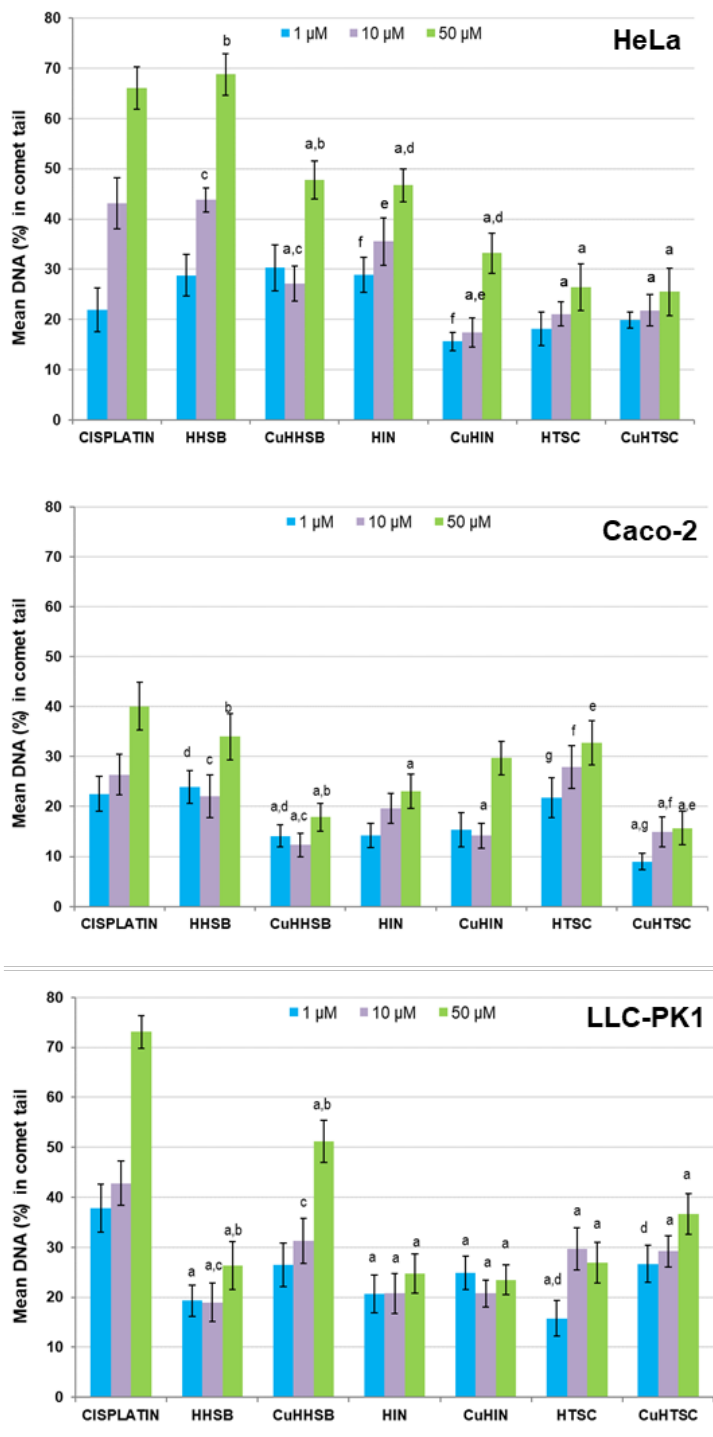
Figure 6. Basic endogenous DNA damage in different cell lines after exposition to tested compounds, expressed as percentage of DNA in the tail of comets in the alkaline comet assay. The number of cells analysed in each treatment was 50. Error bars denote standard error of the mean (S.E.M). Results significantly different from: a cisplatin, b–g Cu ligand; ANOVA ( p ≤ 0.05). In the case of the Caco-2 cell line (Figure 6), 50 µM cisplatin induced the strongest breaks to DNA (40.1% ± 4.8%), while genotoxicity of lower doses was comparable to that of HHSB and HTSC. Moreover, both – HHSB and HTSC in all doses, demonstrated higher genotoxic activity than their Cu ligands ( p ≤ 0.05), and in the case of 50 µM dosage it was